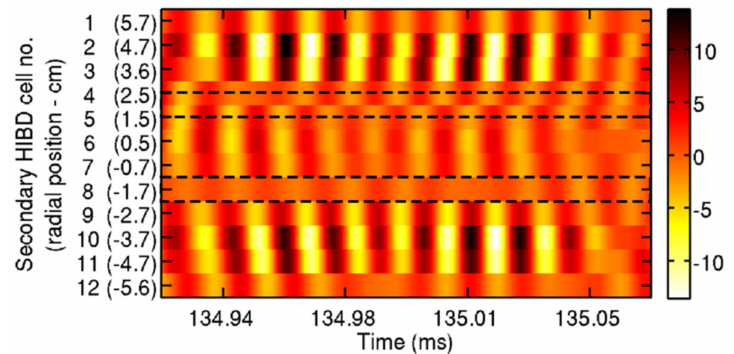
Figure 8. HIBD signals filtered with a 20 kHz bandwidth filter centered at 65 kHz. Dashed line rectangles indicate the location of the phase reversal. The scale is in a.u. (reprinted from [9], with the permission of AIP